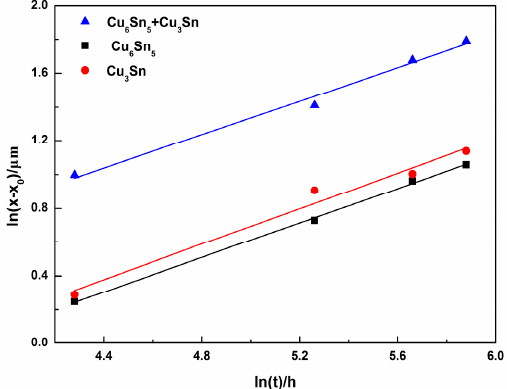
− d 0 ) versus ln( t